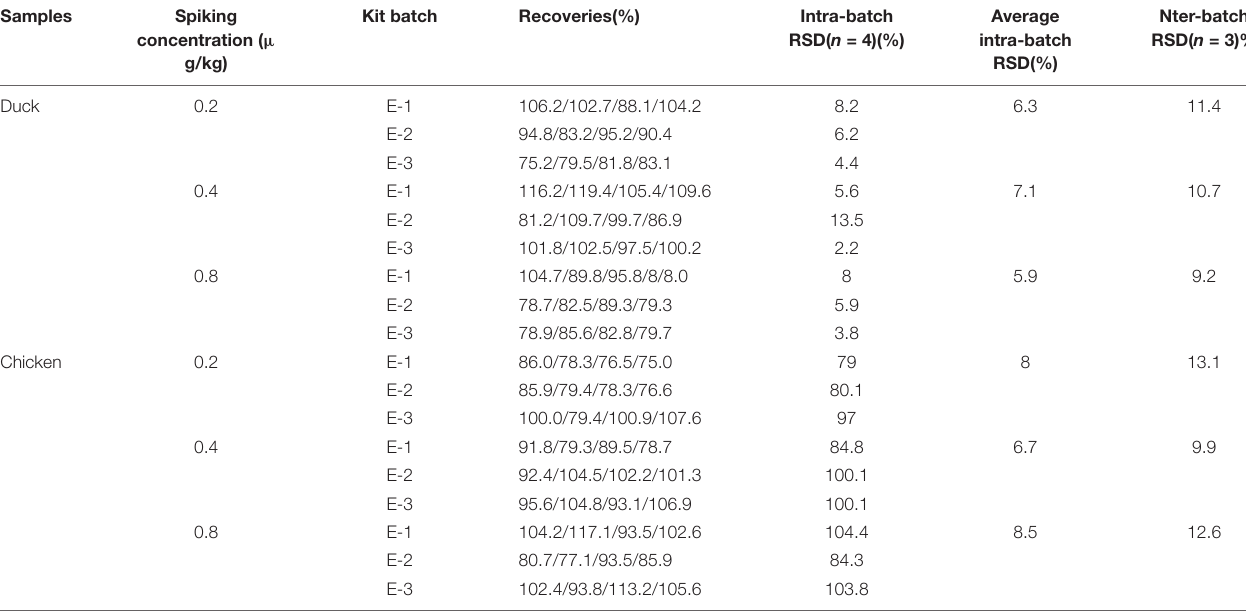
TABLE 4 | Recoveries and RSD of diclazuril from chicken and duck samples.